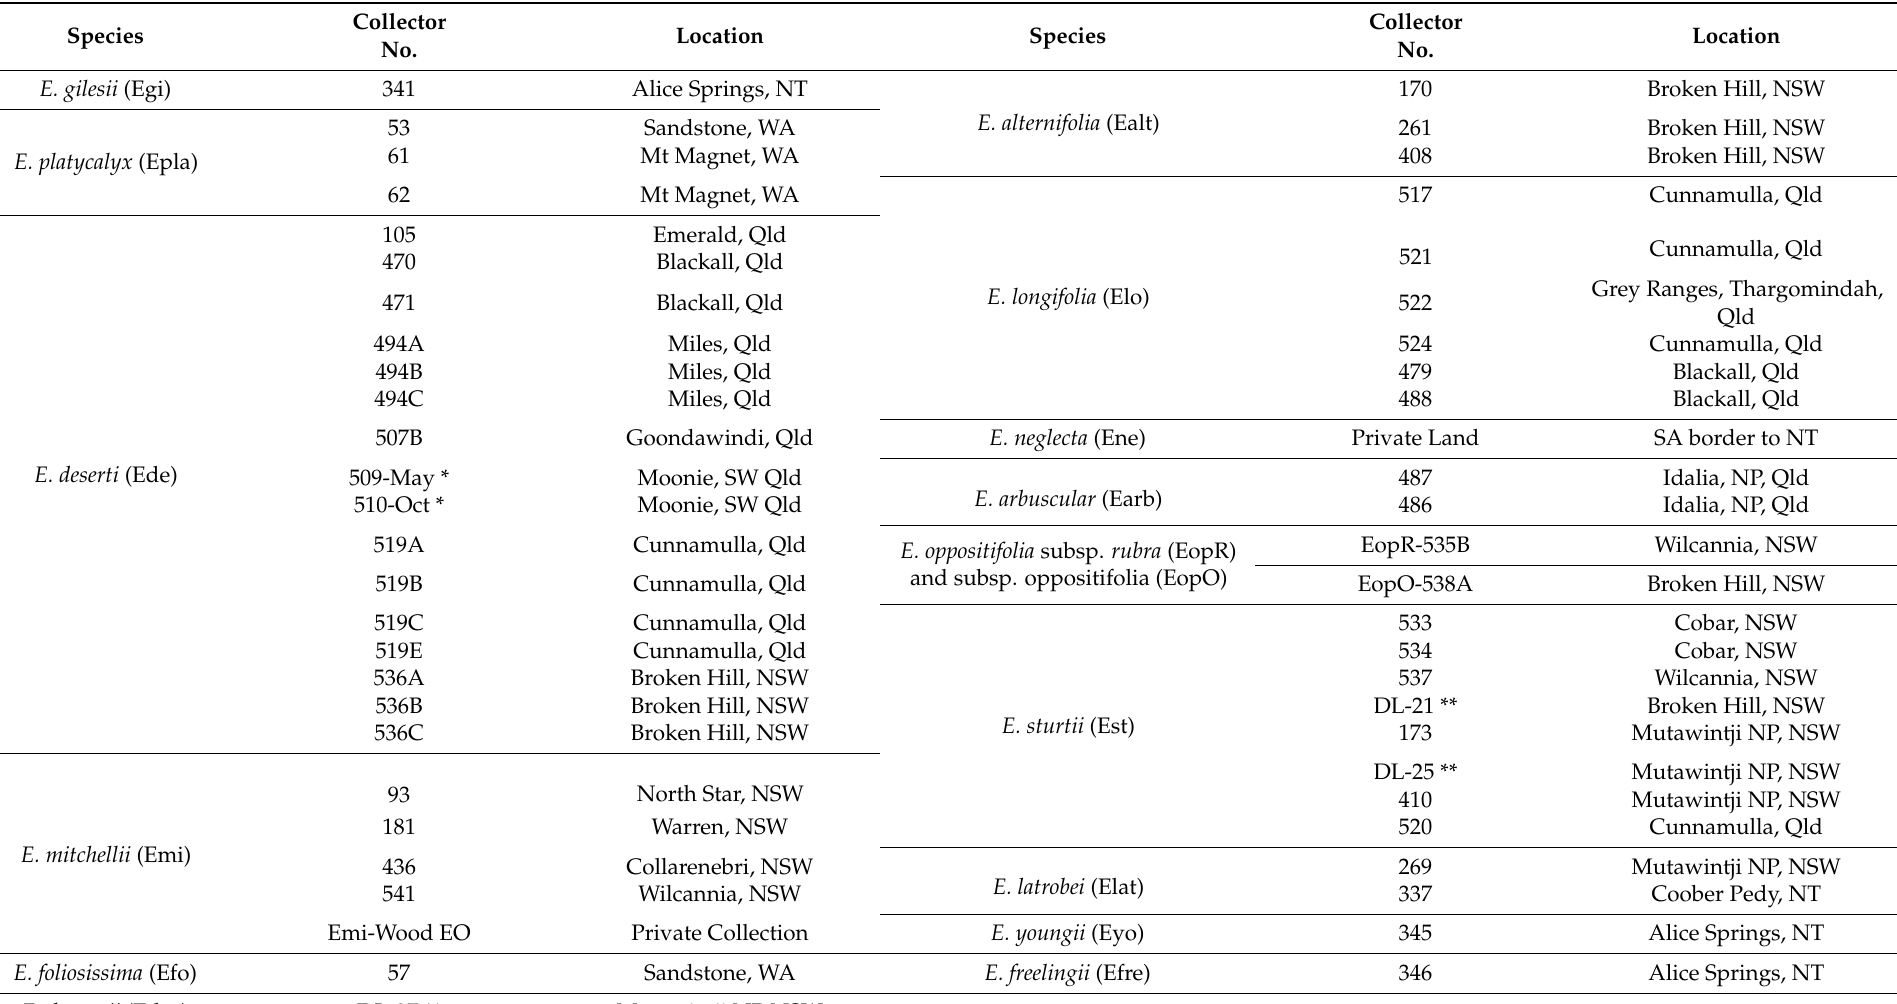
Table 2. Species of Eremophila that were studied by hydrodistillation and chemical analysis of essential oils. All were from leaves except for Emi-Wood Oil.